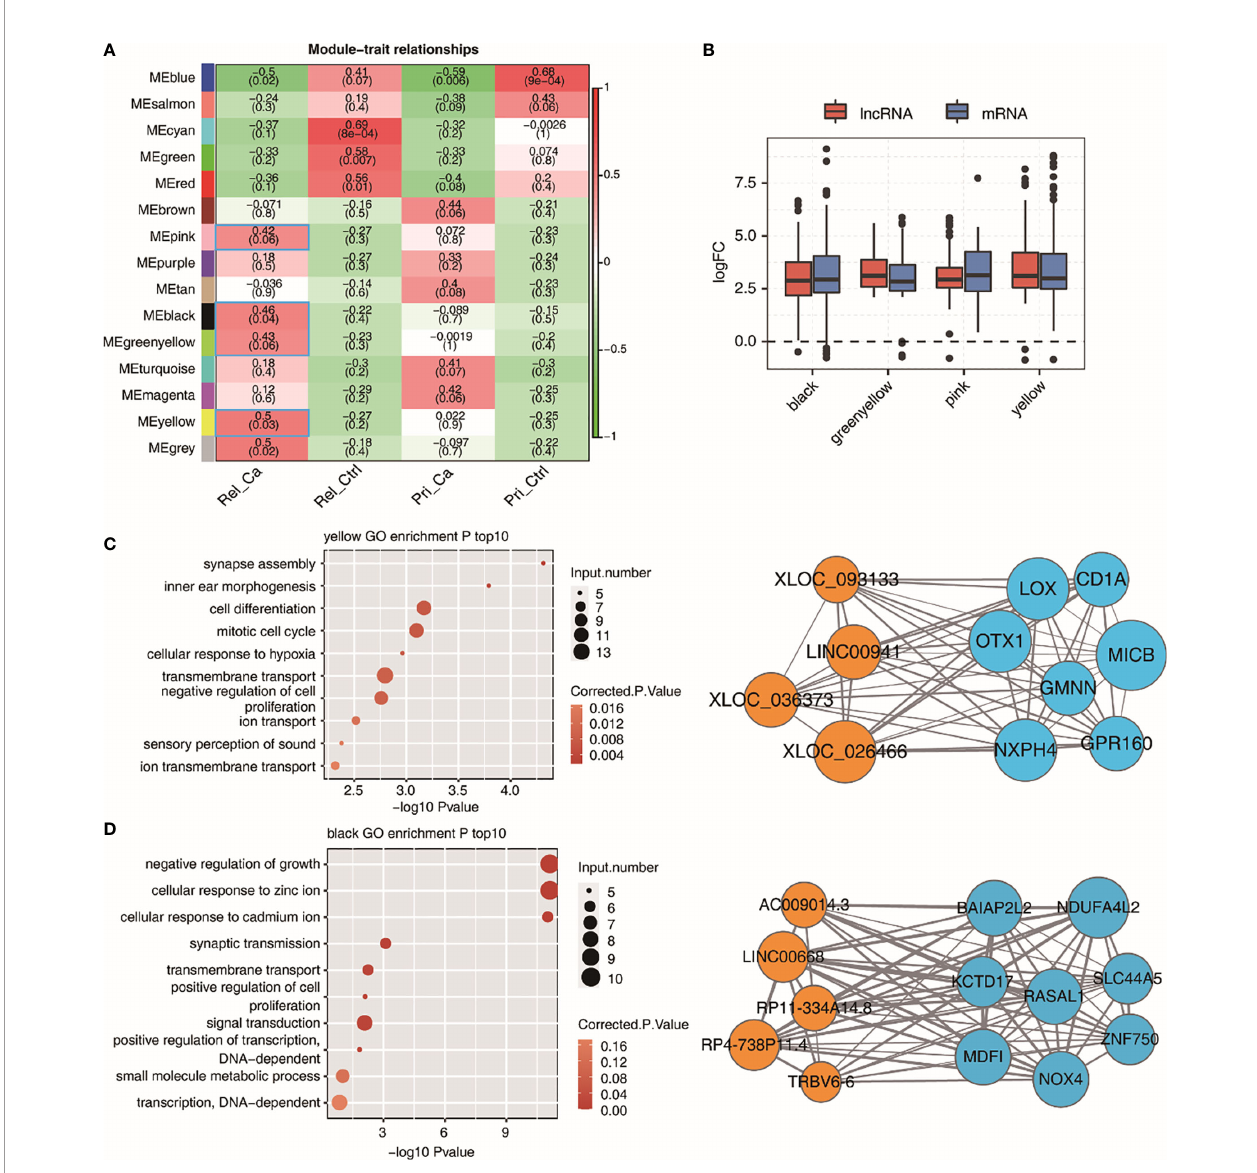
FIGURE 5 | WGCNA analysis of all expressed lncRNAs and mRNAs. (A) Module-trait associations as computed by an LME model with all factors on the x axis used as covariates. All Pearson ’ s correlation value and P values are displayed. Module-traits associations with R and correlation>0.4 were framed with blue box. (B) Boxplot showing expression fold change of mRNAs and lncRNAs from the four relapse associated modules. (C, D) Module plots displaying the top hub genes along with the GO terms enrichment of each of the three modules, MEyellow (C) , MEblack (D) Orange circles indicate lncRNAs and lightblue circles indicate